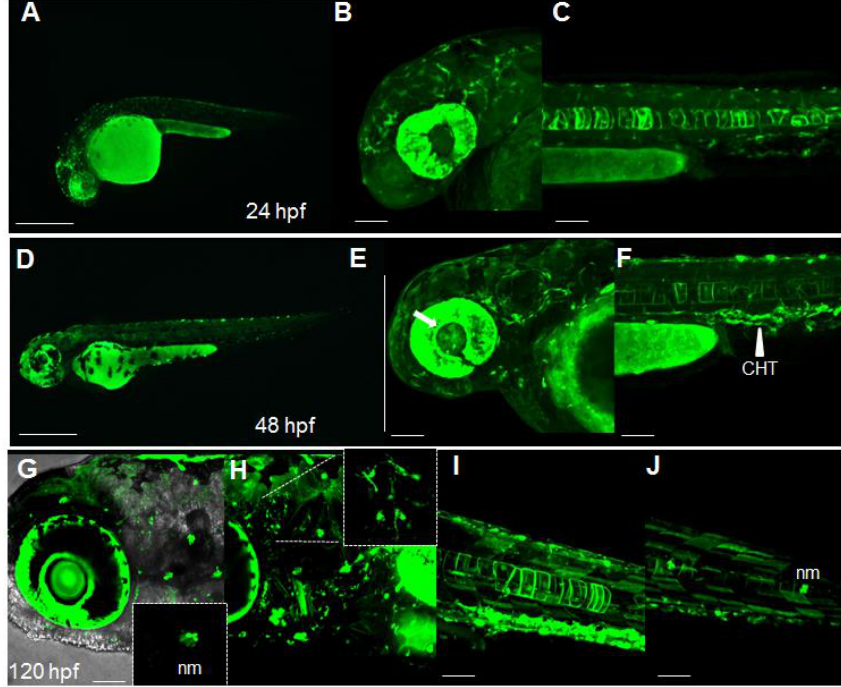
Figure 1. Dynamic spatiotemporal reporter expression in the Nrf2/ARE transgenic line. ( A ) Whole-mount fluorescence microscopy of a Tg(8xAORE:EGFP) ia201 larva 24 hpf, showing the widespread expression of reporter-expressing cells in both cephalic and more caudal regions. ( B , C ) Confocal Z-stack projection of the cephalic area ( B ) and trunk region ( C ) of a 24 hpf transgenic larva in which strong fluorescent cells are detectable in the brain, eye and notochord. ( D ) Whole-mount fluorescence microscopy of a 48 hpf Tg(8xAORE:EGFP) ia201 larva, showing the prolonged expression of the reporter in the cephalic and trunk regions. ( E , F ) Confocal Z-stack projection of the cephalic area ( E ) and trunk regions ( F ) of the same 48 hpf transgenic larva exhibiting novel expression domains in the lens and inner eye (white arrow) and the caudal hematopoietic tissue (CHT) (white arrowhead). ( G – J ) Confocal Z-stack projection of the cephalic area ( G , H ) and trunk regions ( I , J ) of a 120 hpf transgenic larva showing fluorescent neuromasts (nm) and protrusion-carrying brain cells (small inset in H ), as well as muscle fibers along the trunk ( I , J ). All images are lateral views with anterior to the left. Scale bar in ( A , D ): 500 μ m; in ( B , C , E , F ) and ( G – J ): 100 μ m.